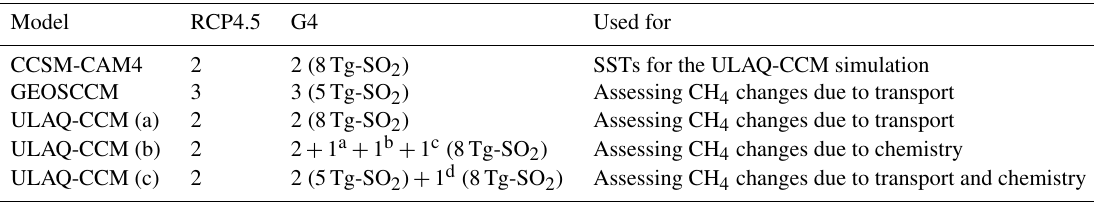
Table 2. Summary of numerical experiments with ensemble size. The amount of injected SO 2 (per year) is specified between brackets in the G4 column.